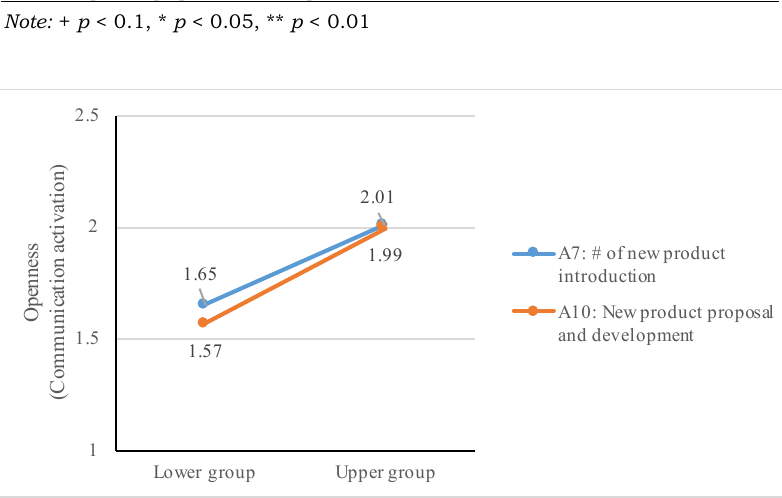
Figure 3. The relationships among A7, A10, and